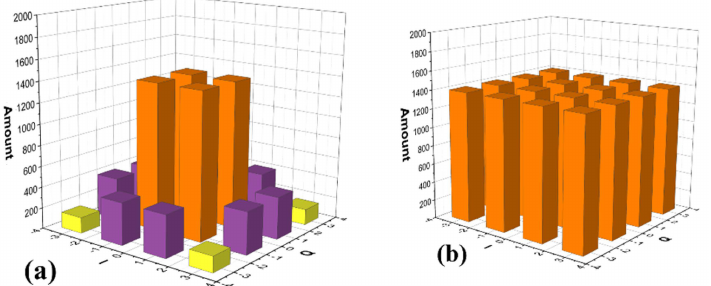
Figure 6. Transmitted PS-16QAM constellation points distribution ( a ) before ROS, ( b ) after ROS. Bars: (Orange: Large amount, Purple: Medium amount, Yellow: Small amount.)